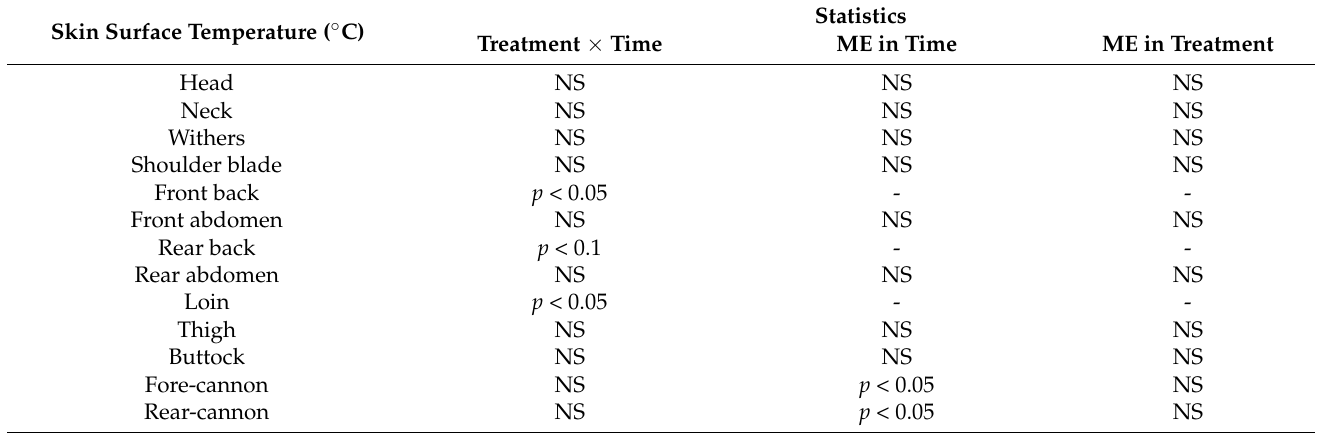
Table 4. Statistics 1 of skin surface